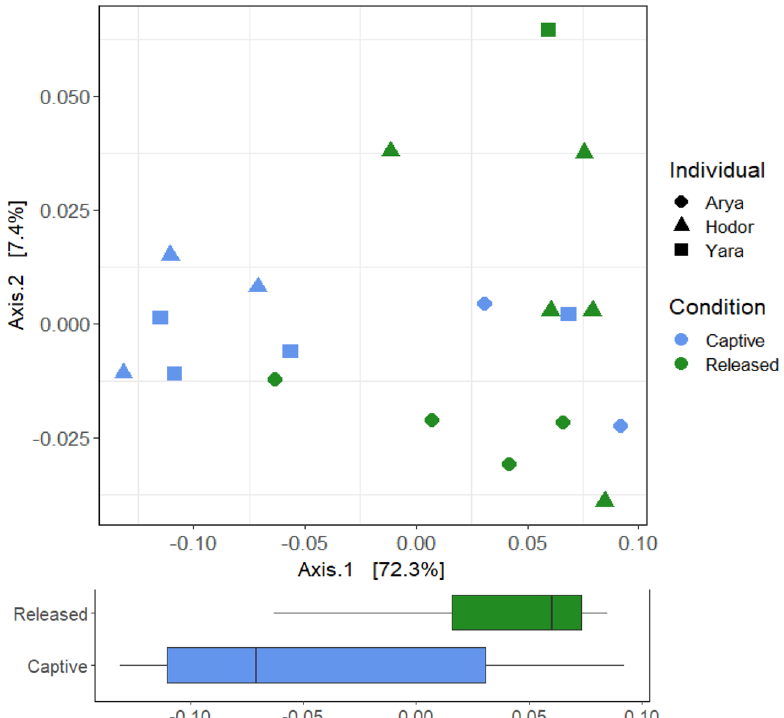
Figure 5. PCoA of bray–curtis distances of PICRUSt functional diversity of 16S rRNA gene amplicons of bacterial communities in primate feces grouped by individual and condition. Samples from recaptured individual are considered as captive in this analysis. Boxplot shows the data dispersion over the first axis of the PCA between samples taken from captive and released indiciduals.